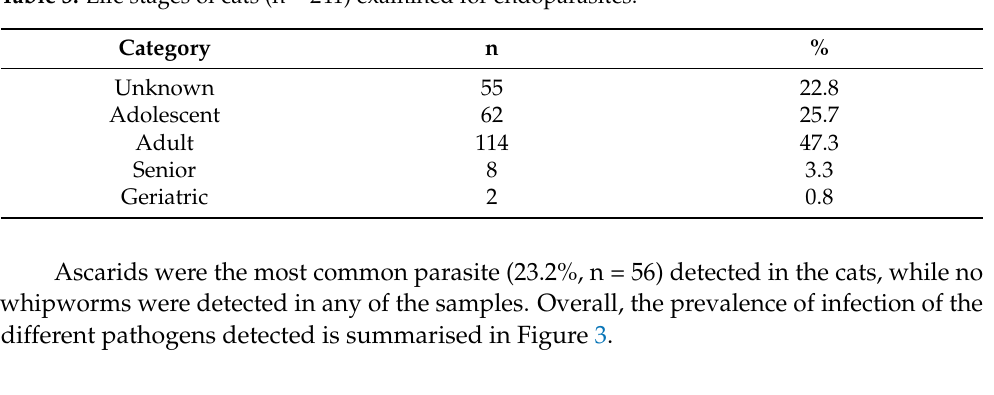
Figure 3. Prevalence of parasites detected in cats.